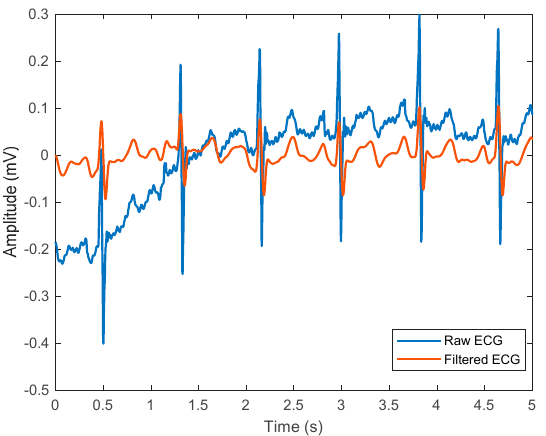
Figure 5. A representation of ECG signals, where the blue line represents raw ECG signal before denoising, and the red line shows filtered ECG signals that are ready for further analyses.